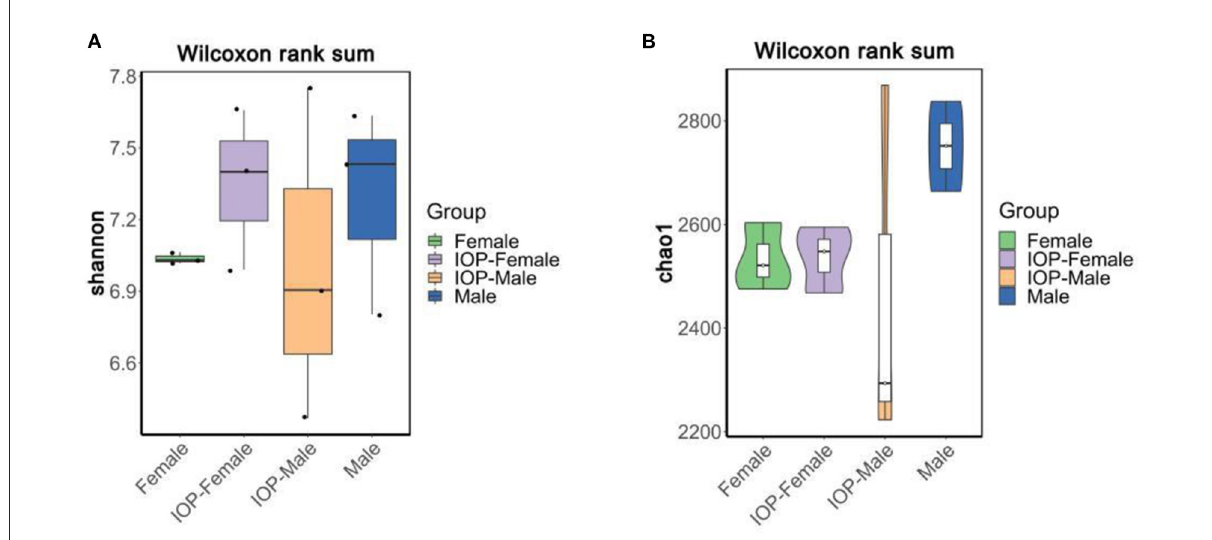
FIGURE3 Alpha-diversity compared based on Wilcoxon rank sum test. (A) Shannon boxplots of all SD rats. (B) Chao1 violin plots of all SD rats.